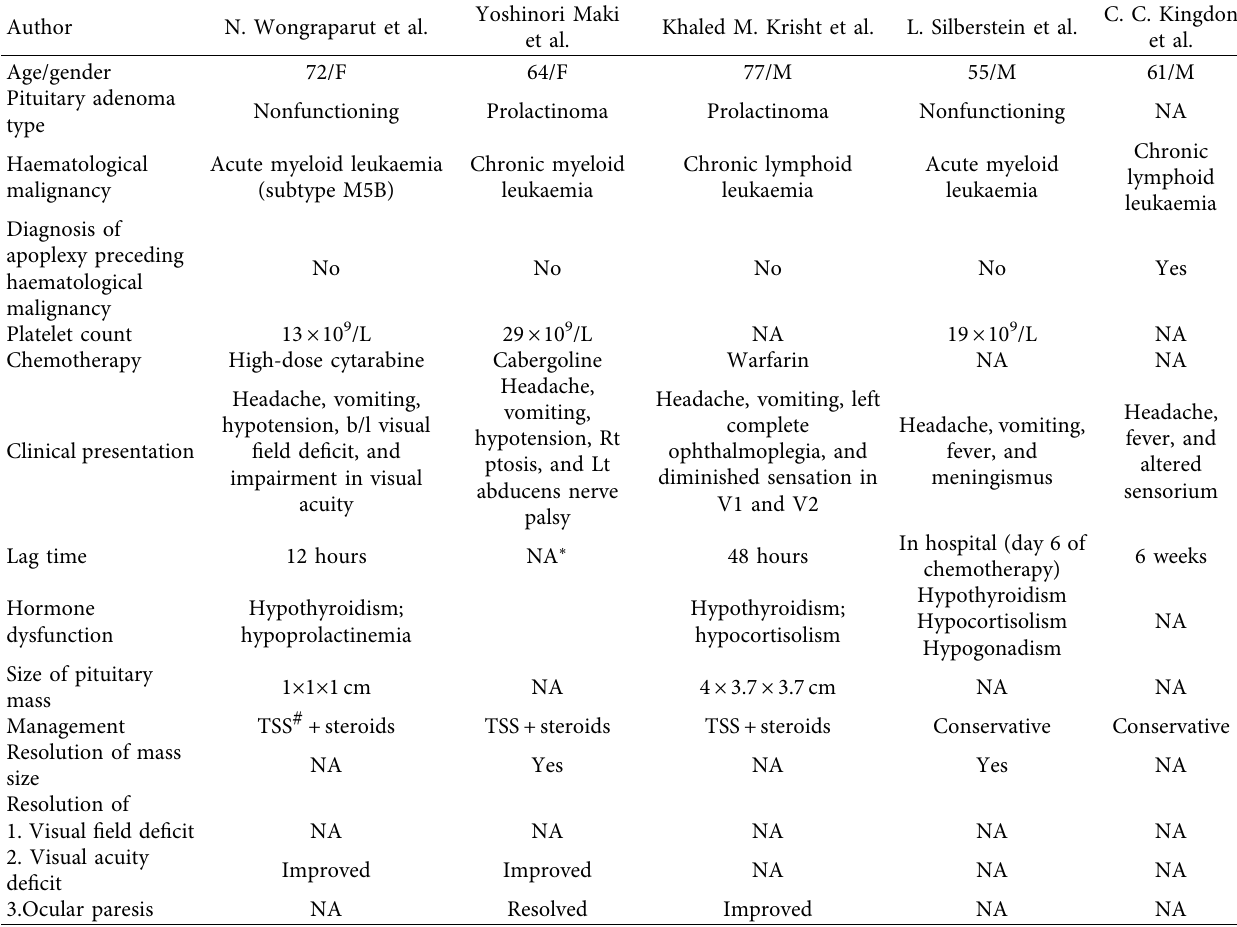
Table 1: Cases of pituitary apoplexy secondary to underlying haematological